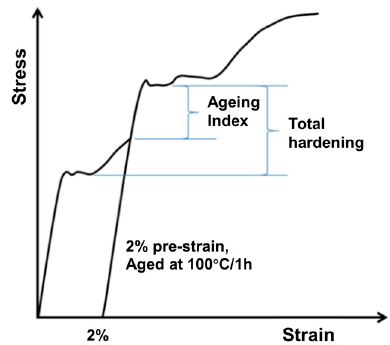
Figure 2. Schematic diagram showing the aging index and the total hardening.